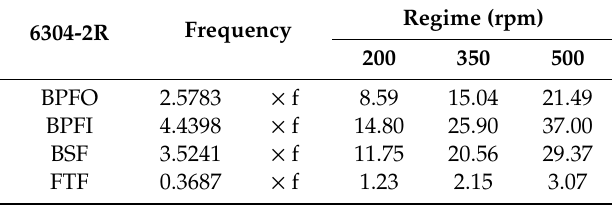
Table 2. Characteristic frequencies of the 6304-2R bearing at di ff erent regimes.